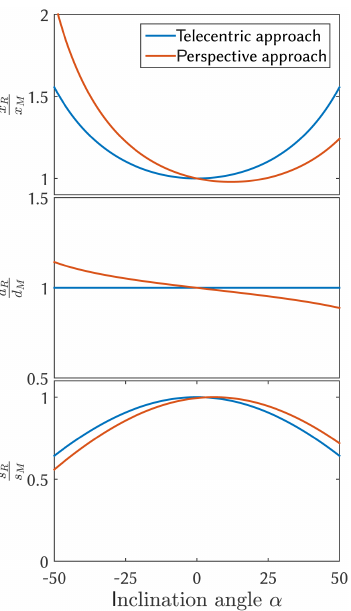
Figure 3. Mean deviations of the plume extent in the x direction ( x R ), plume distance ( d R ) and column density ( s R ), used in the flux determination for the right half of the image plane of an SO 2 camera with an FOV angle of 24 ◦ (for the left half of the detector the incli- nation deviations would be vice versa). The blue lines show the ratio between the ground truth (i.e. the geometric accurate) variables and the measured variables for a telecentric (an orthographic projection where the apparent size does not depend on the distance) approach. The red lines show the same ratio for a perspective approach.